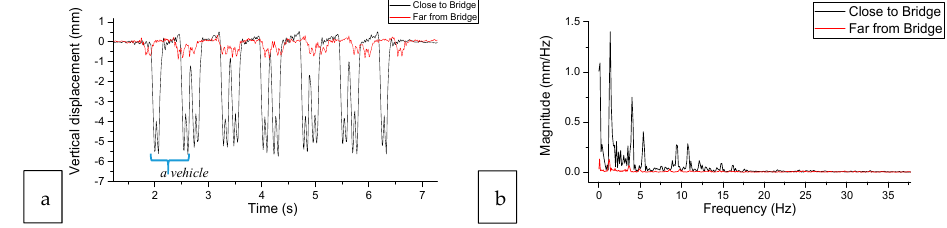
Figure 10. Vertical displacements of rail at 1.5 m and 4.5 m of the transition: ( a ) in the time domain, ( b ) in the frequency domain.